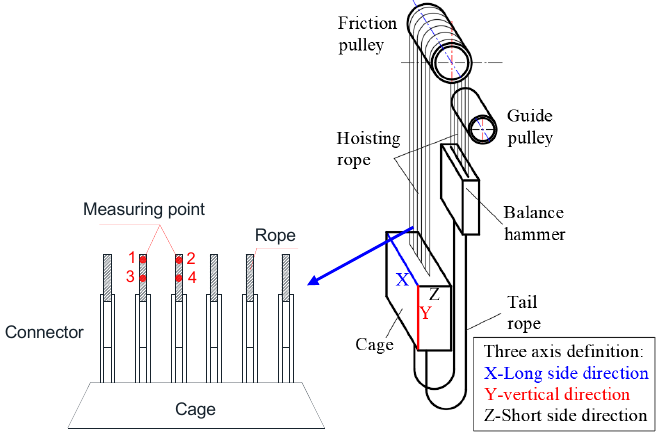
Figure 5. Vibration testing scheme of the wire rope above the cage. Appl. Sci. 2020 , 10 , 1305